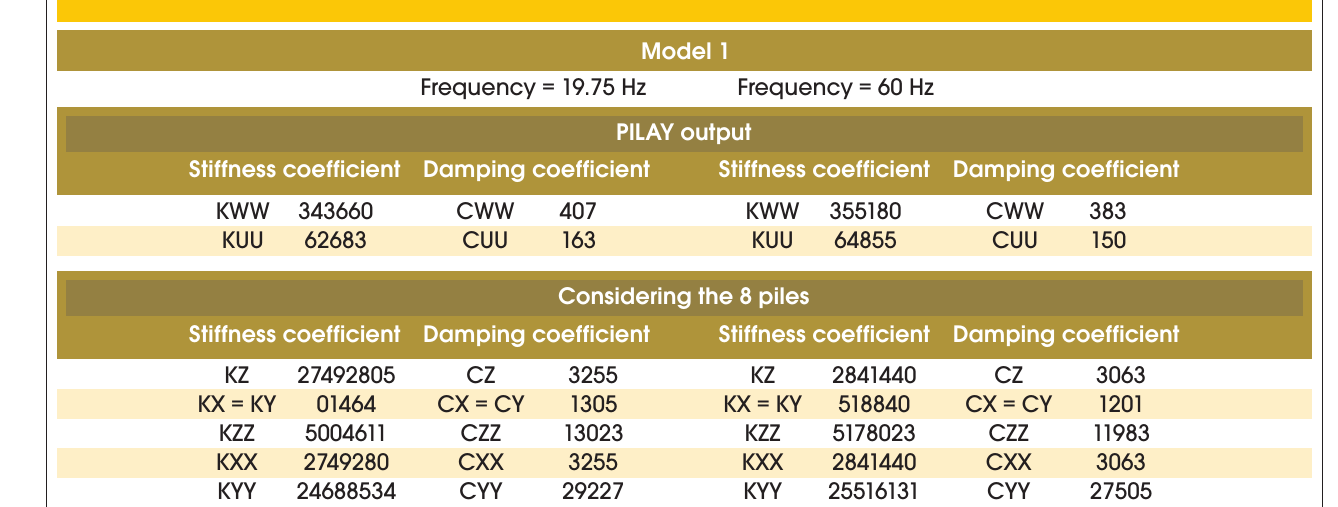
Table 8 – Stiffness and damping coefficients – Model 1